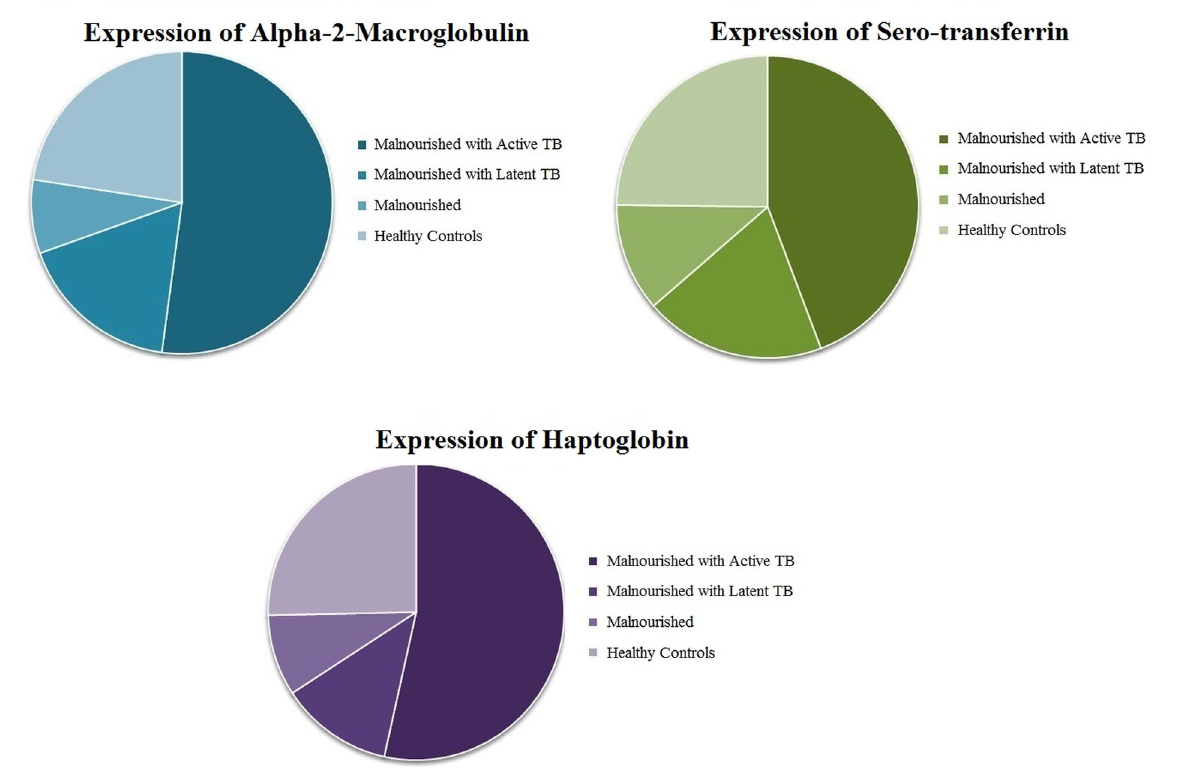
Fig 5. Expression of proteins by densitometric analysis. Pie charts represent the intensities of protein bands assessed by densitometric analysis in different study groups. Gel analysis was done using Image Lab software (BioRad) (Version 4.0)